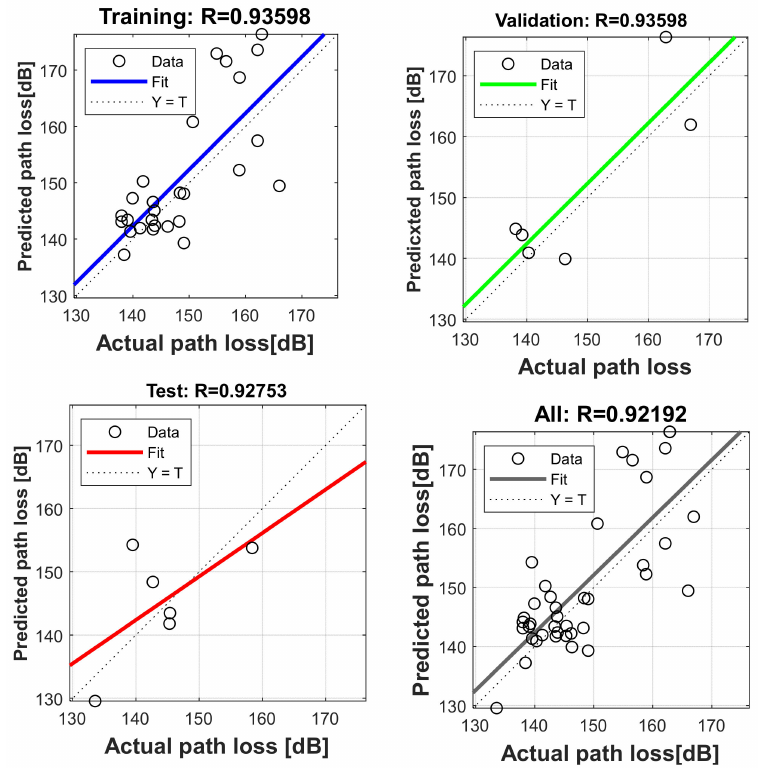
Figure 14. Prediction performance with correlation coefficient in site